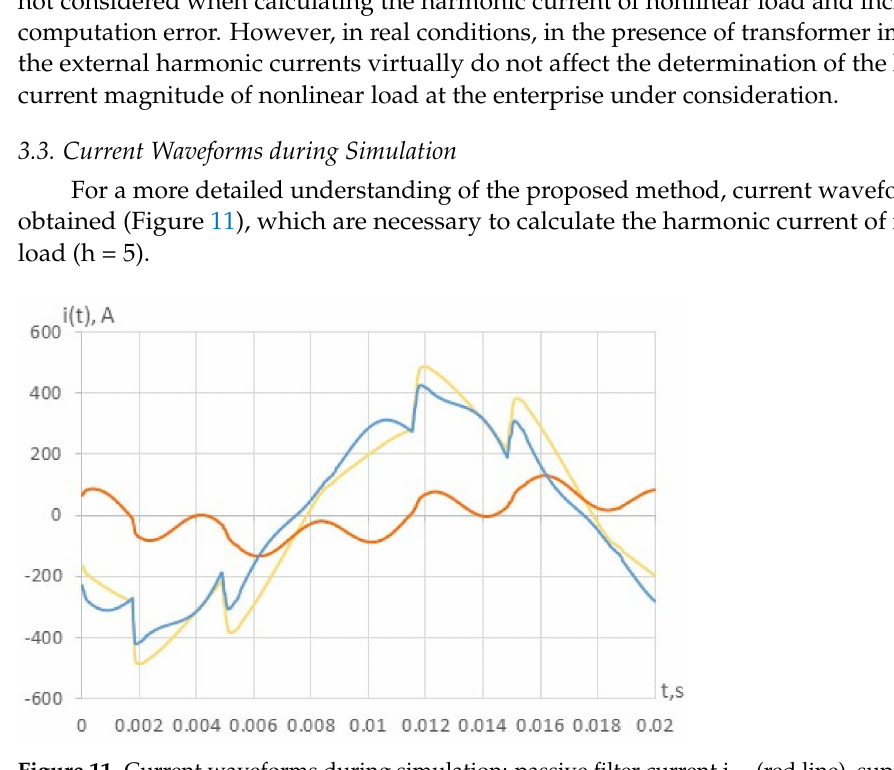
Figure 11. Current waveforms during simulation: passive filter current i PF (red line), supply system current i T (blue line), calculated current i SUM (yellow